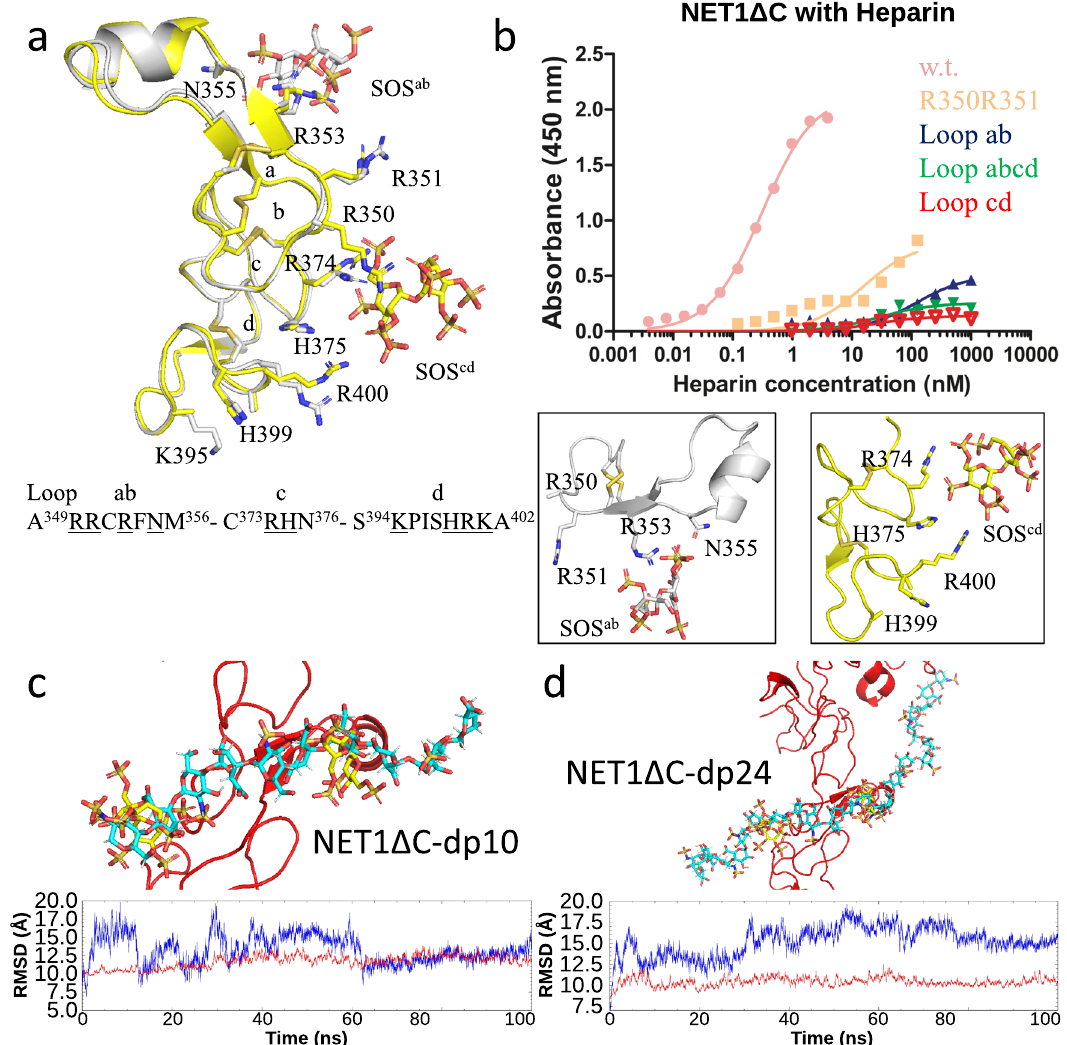
Fig. 3 | Molecular details of the NET1 Δ C - SOS interaction. a SOS ab (silver) and SOS cd (yellow) binding motifs from our X-ray crystal structure. Individual loop segments are labelled a – d , accordingly. Amino acid residues studied in mutagen- esis experiments are underlined and depicted as loop ab (RRXRXN), loop cd (RH- KHRK) mutant versions. b ELISA-based GAG-binding studies of wild type NET1 Δ C and mutant versions of NET1 Δ C. The coordinates of the mutated residues at the